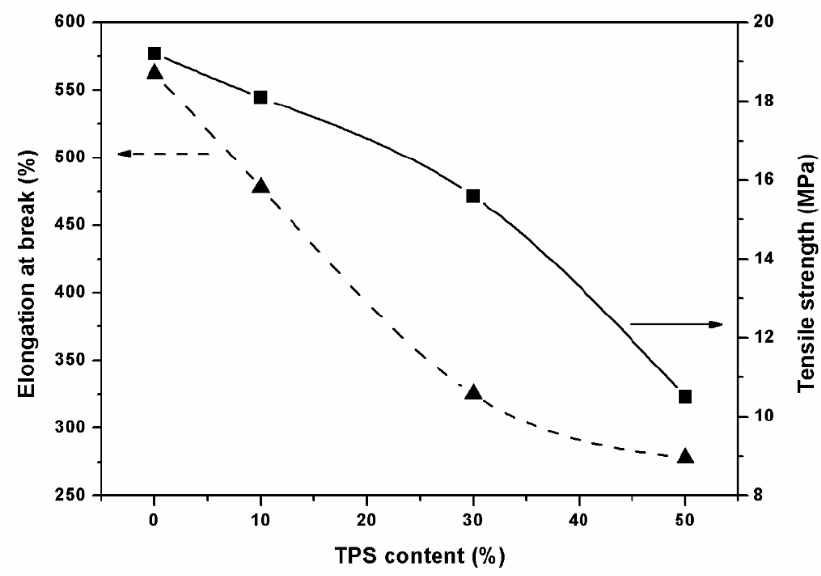
Figure 2. Effects of starch content on tensile properties of the TPS/PBSA blend. When the content of TPS was too much, the interaction of TPS with the PBSA matrix was enhanced, which limited the movement of PBSA segments. Moreover, with the increase of TPS content, the TPS tended to agglomerate and separate from PBSA, which lead to the performance degradation of the